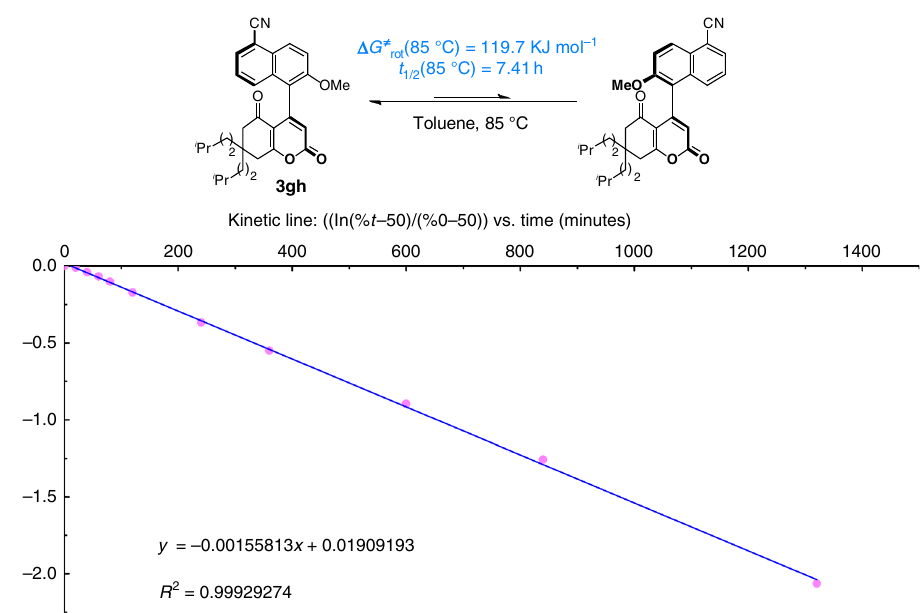
Fig. 3 Determination of the enantiomerization barrier. Reaction conditions: 3 mg of enantio-enriched 3gh were re fl uxed in 15 mL of toluene at 85 °C. Samples of 7 µ L of this solution were injected on Chiralpak IC (heptane/iPrOH = 80/20, 1 mL min − 1 , UV detection at 254 nm) to monitor the percentage decrease of the second eluted enantiomer over